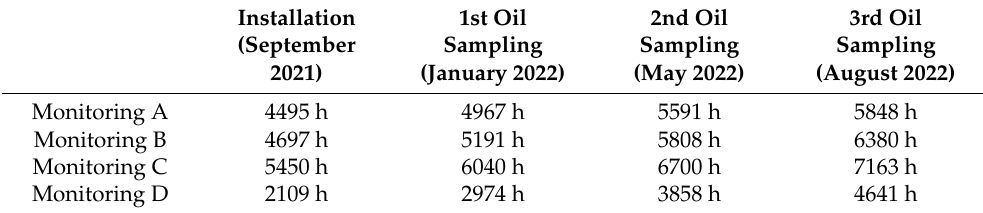
Figure 3. Schematic diagram of the excavator hydraulic system. Table 5. Schedules of periodic oil sampling (Engine operating